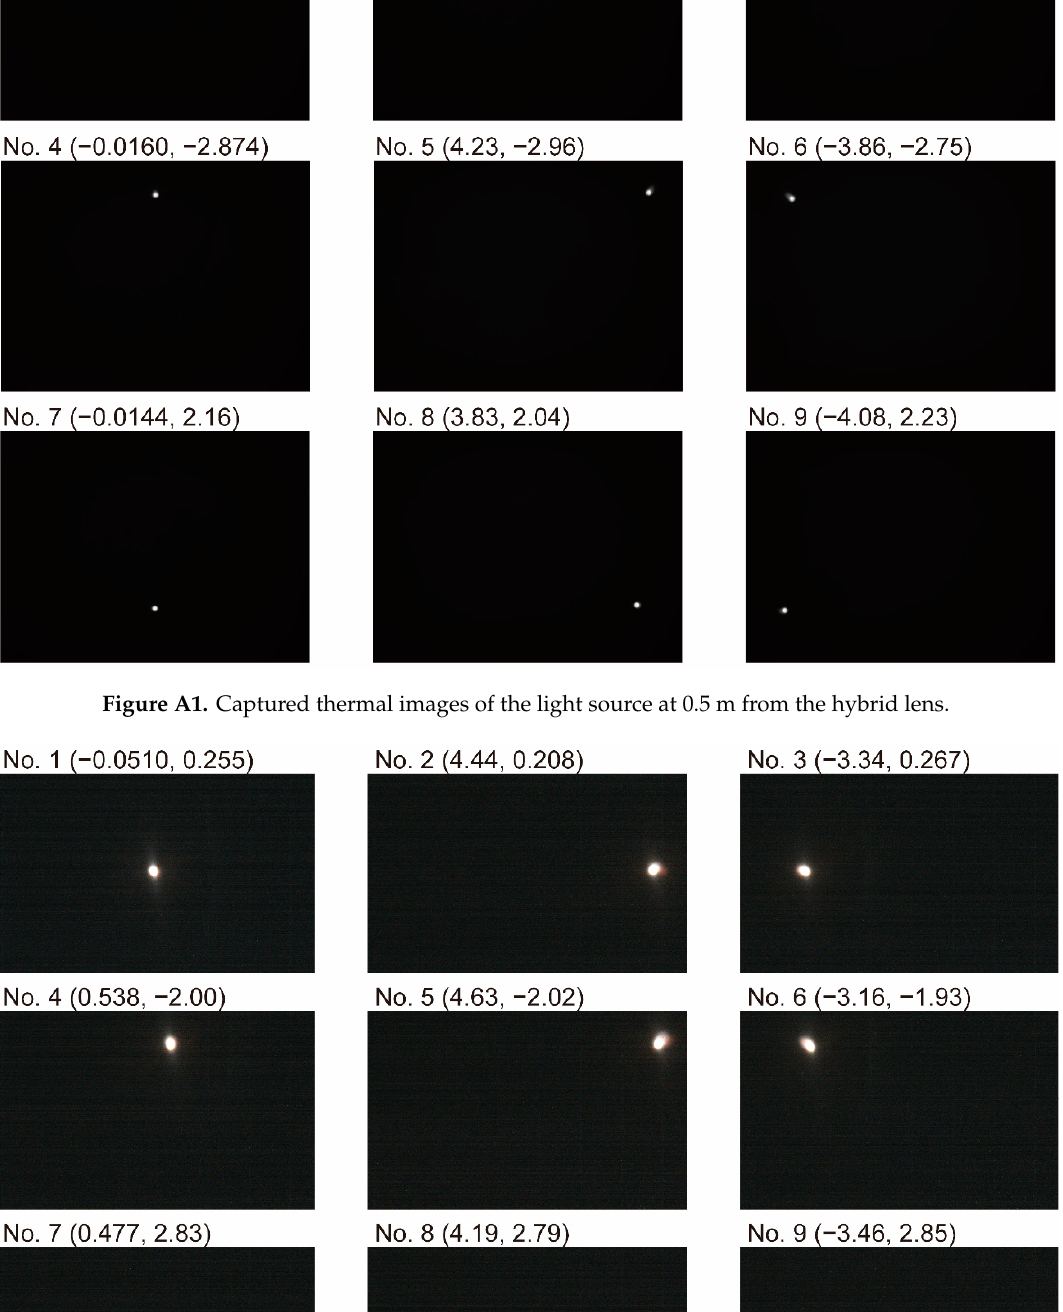
Figure A3. Captured thermal images of the light source at 1 m from the hybrid lens.